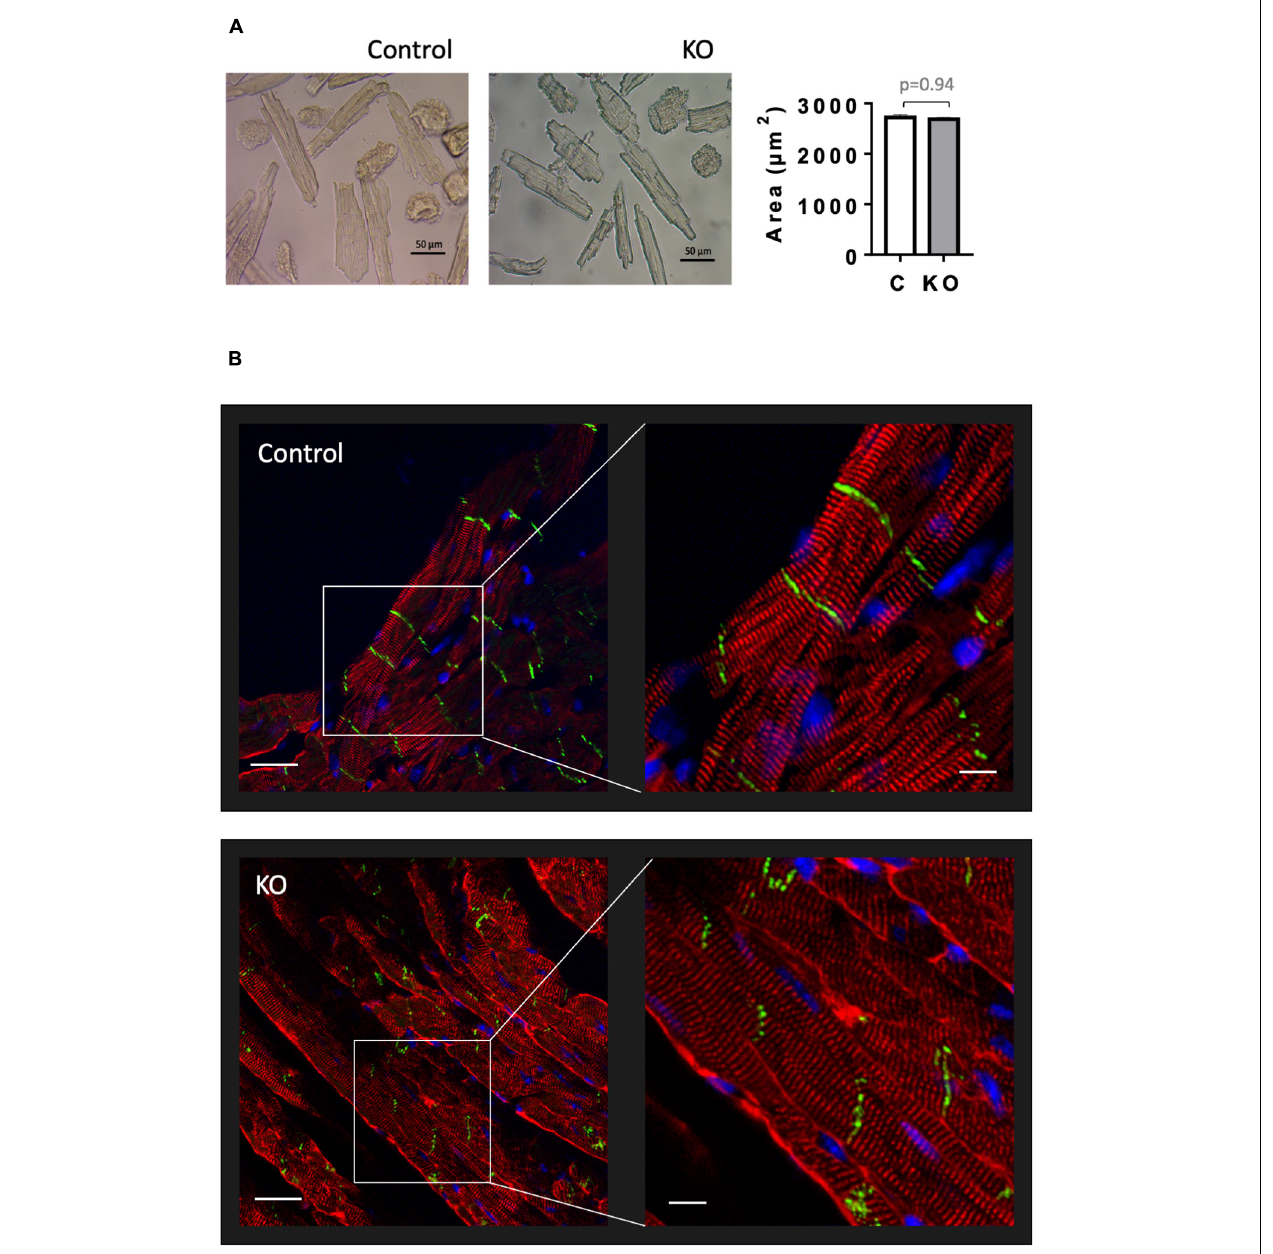
FIGURE 6 | Cardiomyocyte size and cardiac cytoarchitecture in control and AMPK α 1 α 2-KO mice. (A) Isolated cardiomyocytes from control and AMPK α 1 α 2-KO mice 6 weeks after tamoxifen administration; the images were captured by an inverted brightfield microscope and quantified using ImageJ. Scale bars are 50 µ m. Control (white bar), KO (gray bar). The size of isolated cardiomyocytes is given as mean ± SEM ( n = 3 hearts from each group; 100 cardiomyocytes/heart); comparison between two groups was done using t -test. (B) Immunofluorescence confocal microscopy of heart cryosections stained with the Z-disk protein sarcomeric α -actinin (red), the cell-cell contact protein N-cadherin (green) and the nuclear stain DAPI (blue). Scale bars are 30 and 10 µ m for left and right panels,